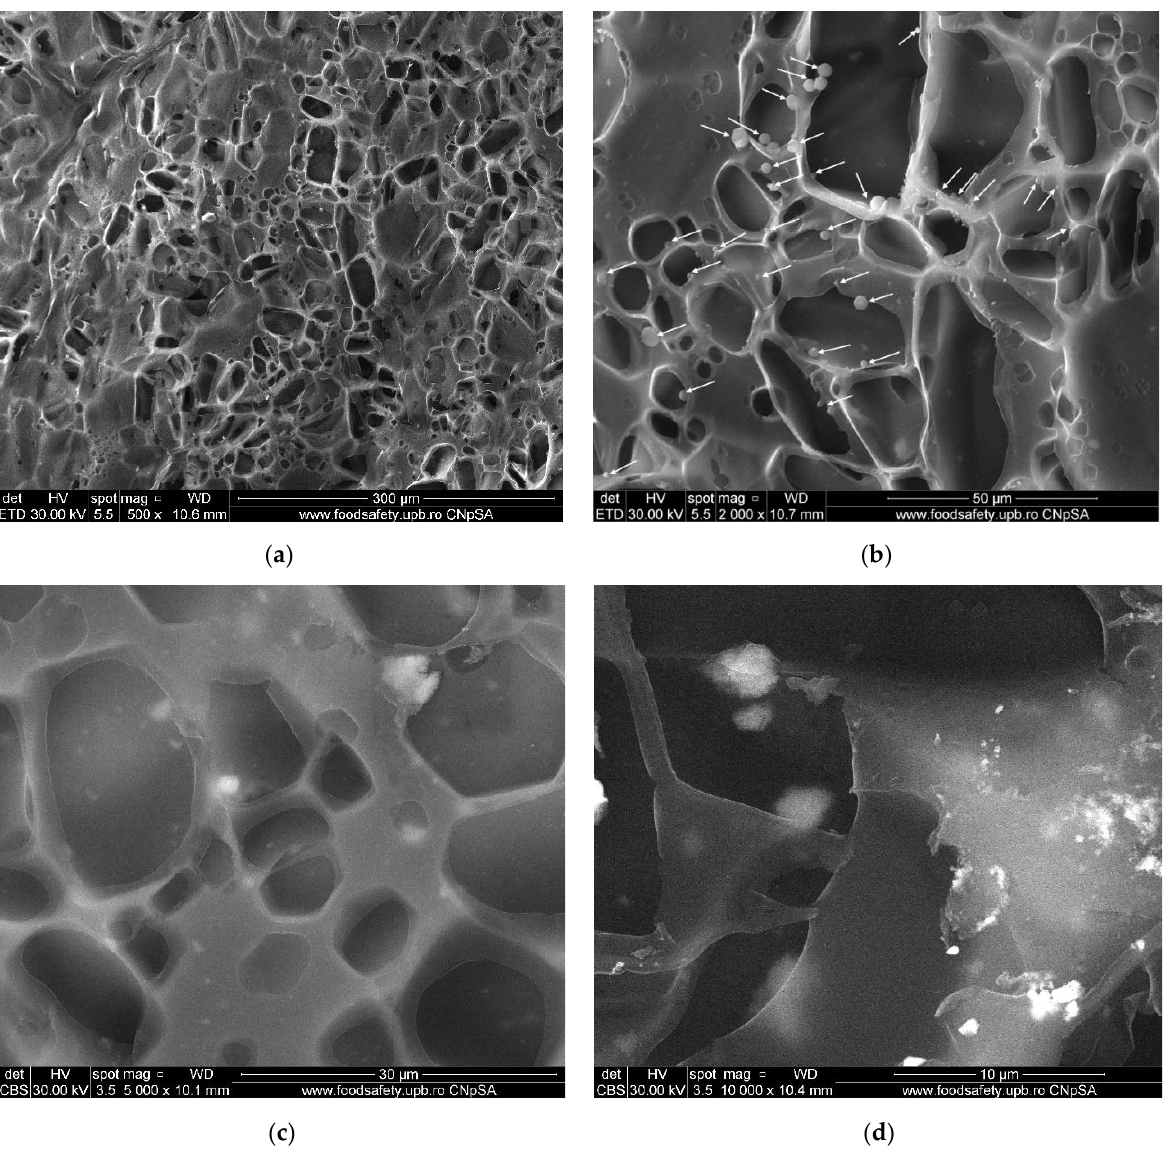
Figure 9. SEM images of chitosan/TiO 2 1%: ( a ) 500× magnification, ( b ) 2000× magnification, ( c ) 5000× magnification and ( d ) 10,000× magnification.